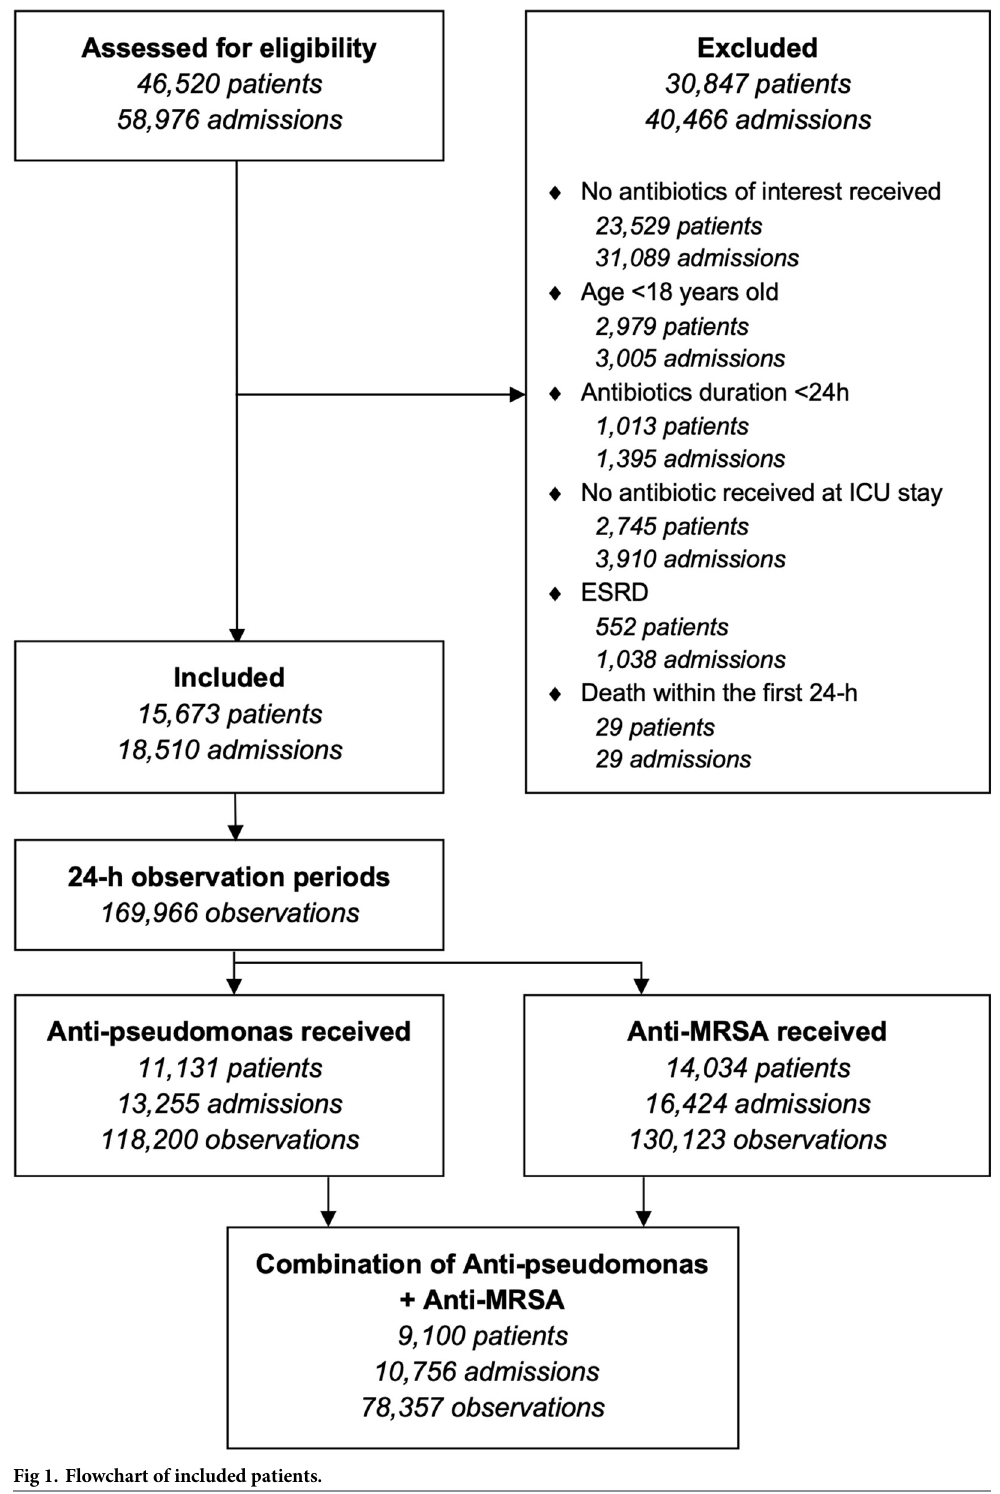
Fig 1. Flowchart of included